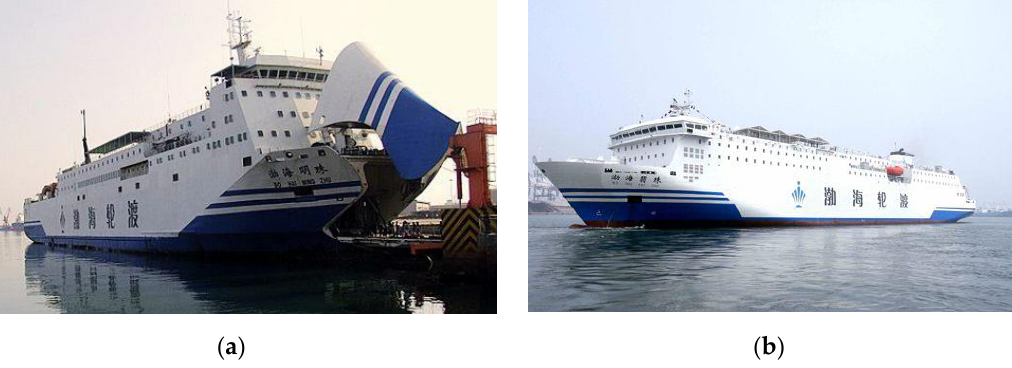
Figure 18. Comparison of the results between the AIS map and HBR map of maritime targets (T2 time: 10:45:02, range: 29.25 km): ( a ) AIS map; ( b ) HBR map.